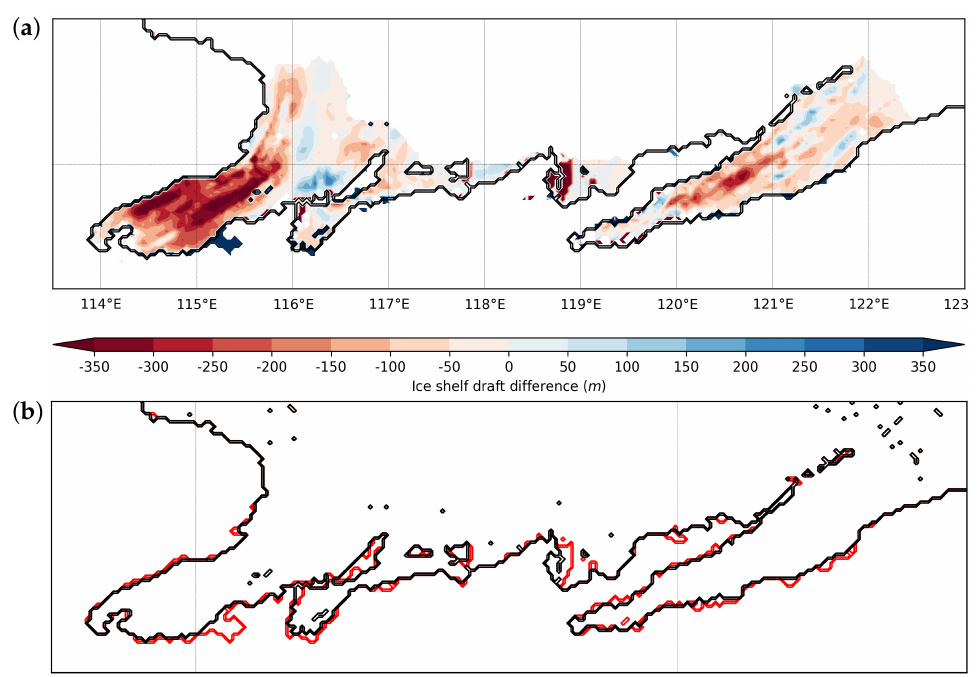
Figure 15. ( a ) Changes in ice shelf draft after 20 years in WARM3mcpl. The loss of ice is in red and gain of ice in blue. The changes are relative to the initial ice shelf draft depth. ( b ) Changes in grounding line position throughout the coupled run. The black and red lines are the initial and final grounding line positions,